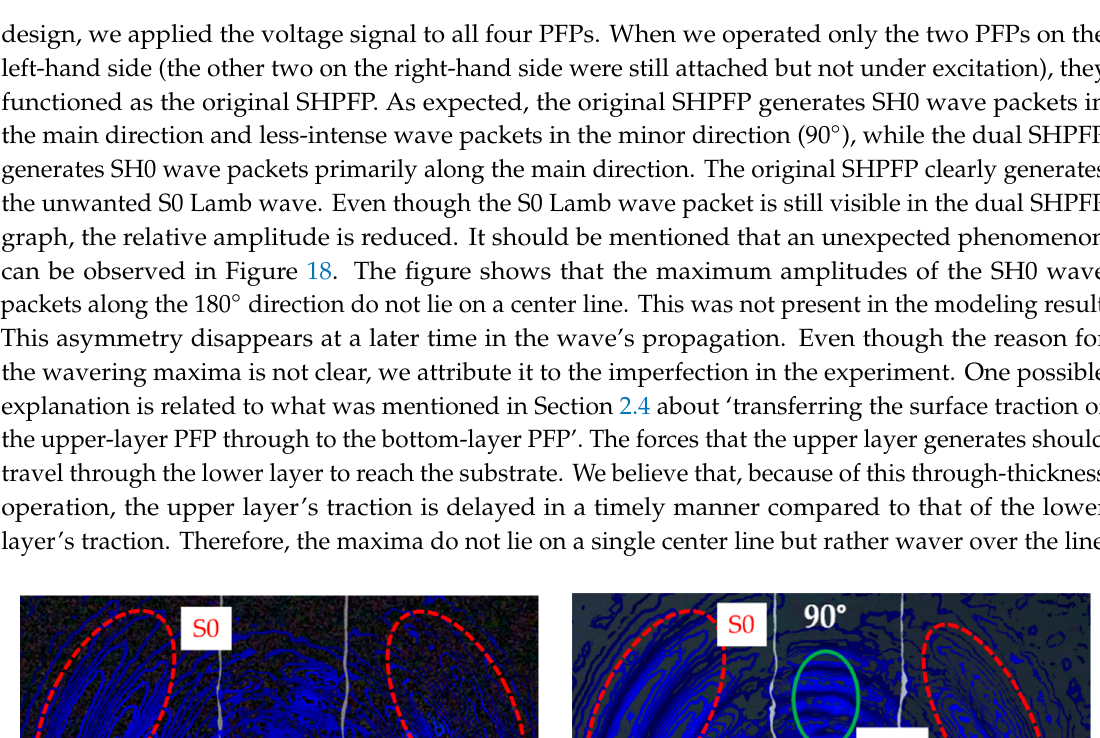
Figure 19. Polar diagrams showing the SH0 amplitude (blue lines) together with the S0 Lamb wave amplitude (orange lines) of ( a ) the dual SHPFP and ( b ) the original SHPFP.